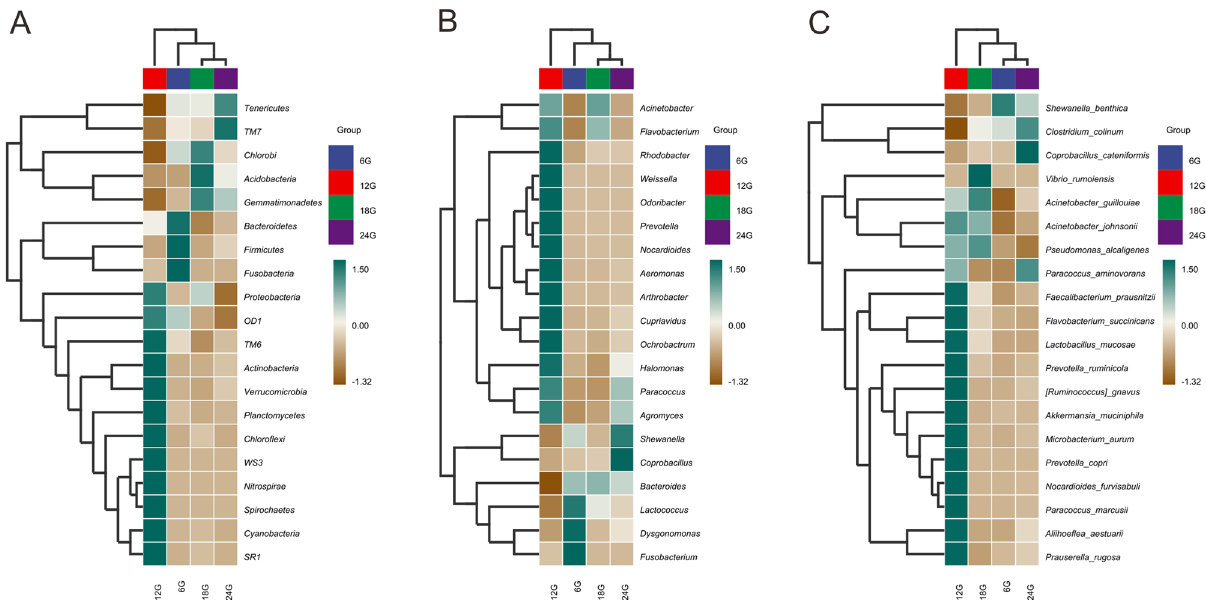
Figure 2. Correlation analyses of the gut bacteria at the phylum level ( A ), genera level ( B ), and species level ( C